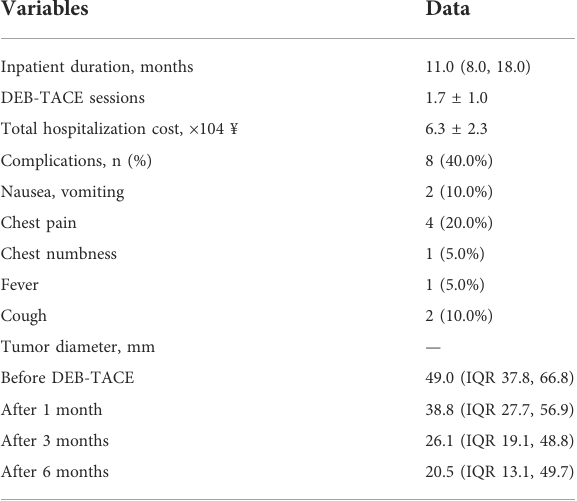
TABLE 2 Clinical data on